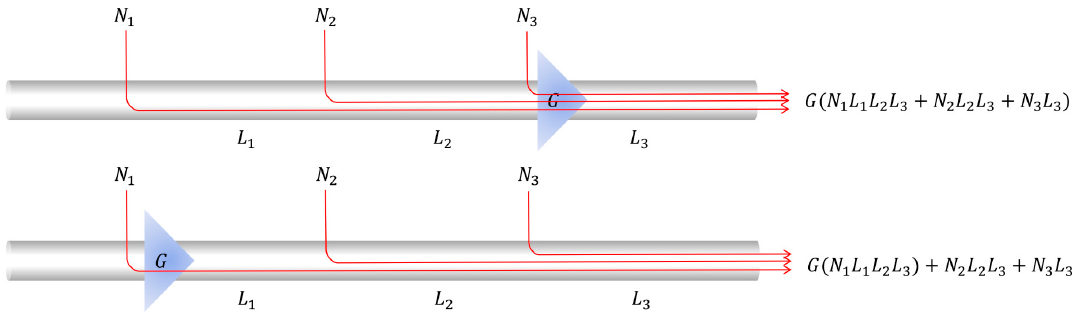
Figure 5. Example of cumulated crosstalk noise according to the SOA placement.